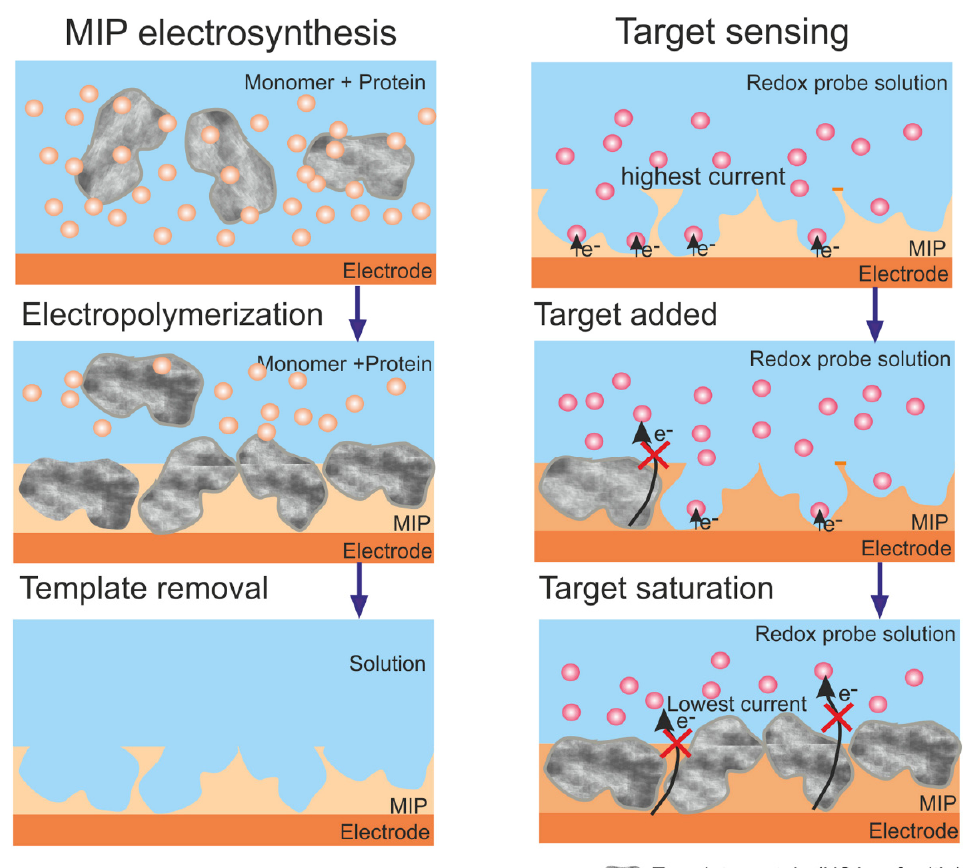
Figure 17. Schematic illustration of the electrosynthesis of surface-imprinted polyscopoletin nanofilm on a gold electrode surface and its use for the detection of the target proteins. Reprinted from [99] with permission from Elsevier.